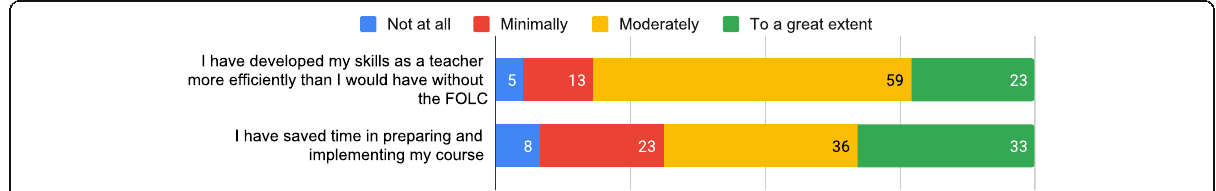
Fig. 8 Time and efficiency. Percentage of respondents reporting benefits to participating in the FOLC in spring 2019 (end of year 2 of the FOLC). Participants rated the extent to which each benefit had occurred as a result of their participation in the FOLC. Items were not presented to participants in this order or identified with the category time and efficiency . ( N =